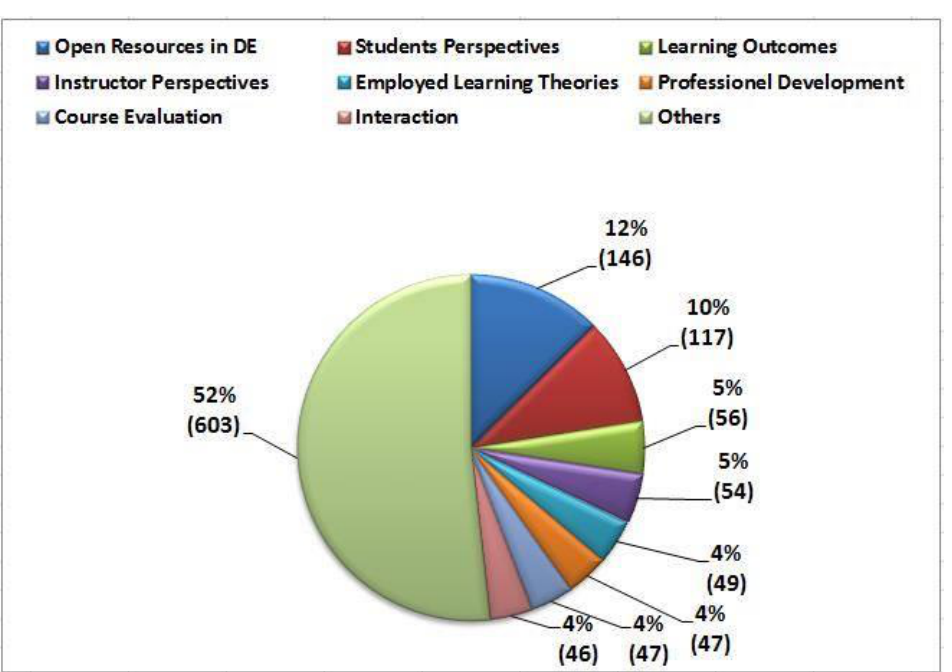
Figure 8. The major concepts studied in the development of